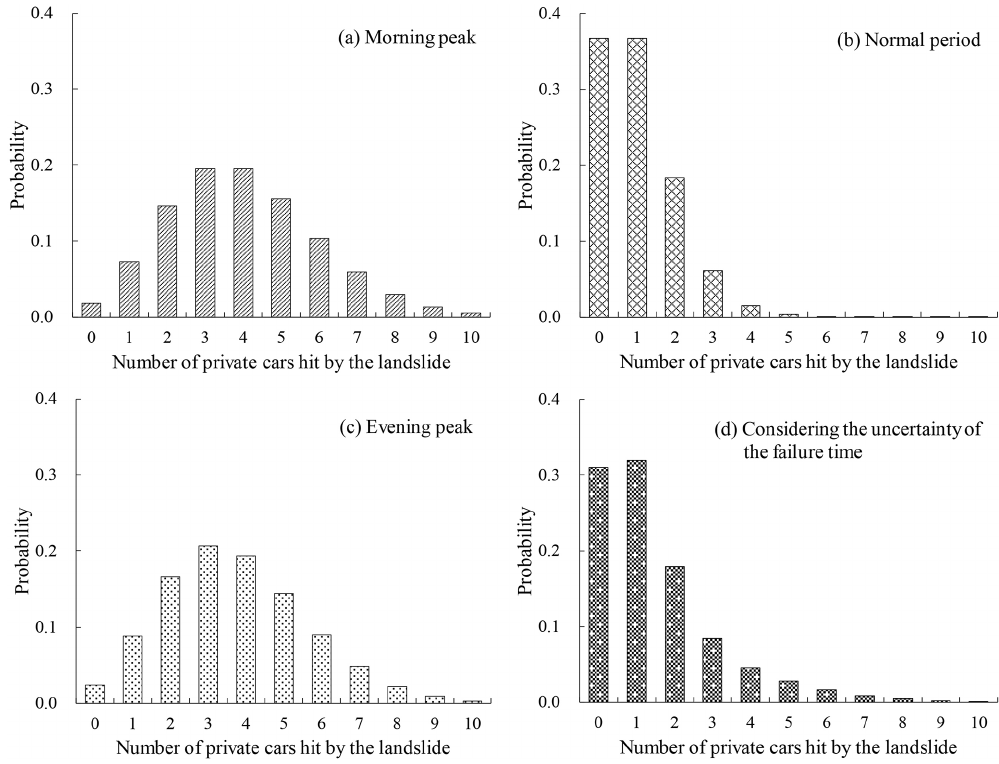
Figure 9. Probability distribution of the number of private cars hit by the landslide studied in this paper during different periods when the spatial impact is S i and α j (S = S i ) = 1: (a) morning peak, (b) normal period, (c) evening peak and (d) considering the uncertainty of the failure